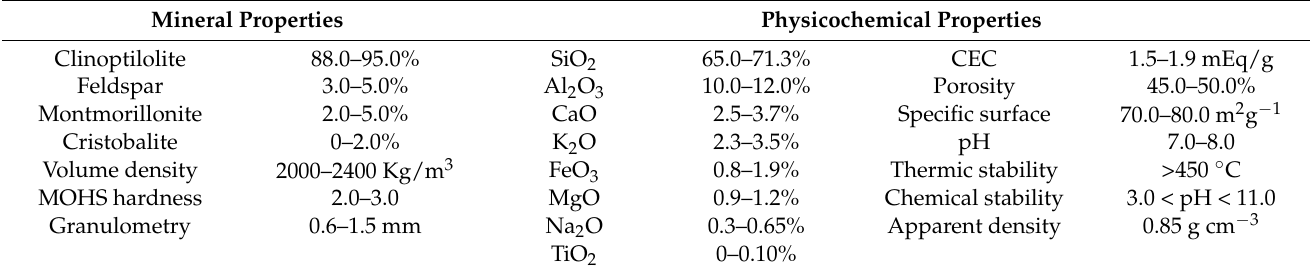
Table 9. Selected properties of zeolites used in this experiment (data provided by the